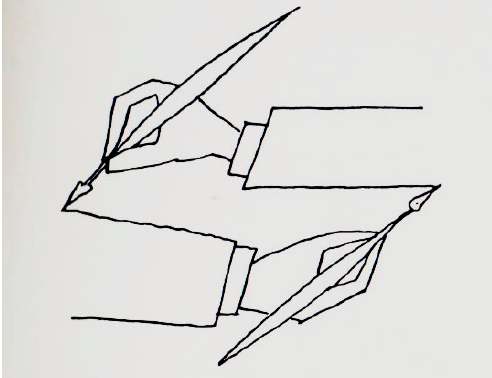
Figure 3. S. Steinberg, from The Passport ,